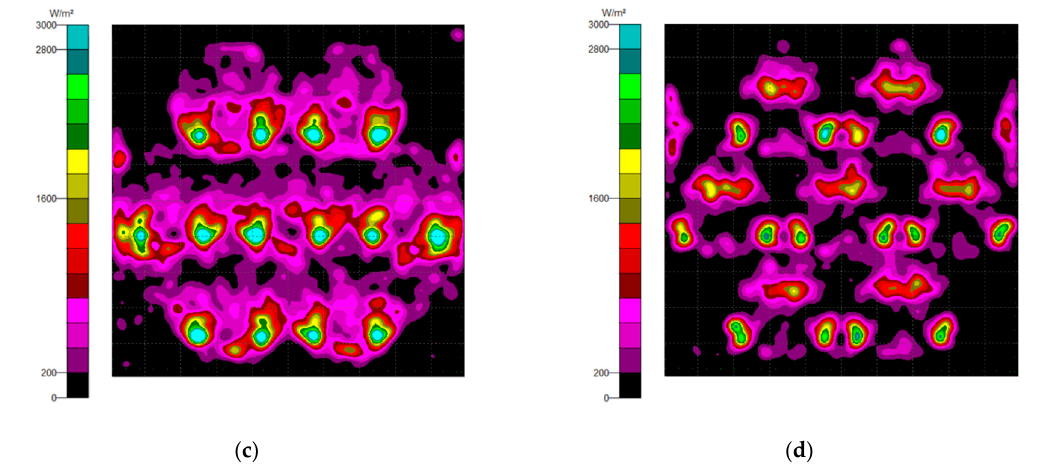
Figure 26. The irradiance distribution of the misalignment light-guiding unit array at misalignment angles of ( a ) 0°, ( b ) 10°, ( c ) 20°, and ( d ) 30°.